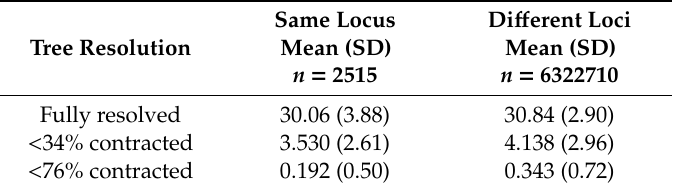
Table 4. Number of incompatible branches between intron indel vs. nt gene